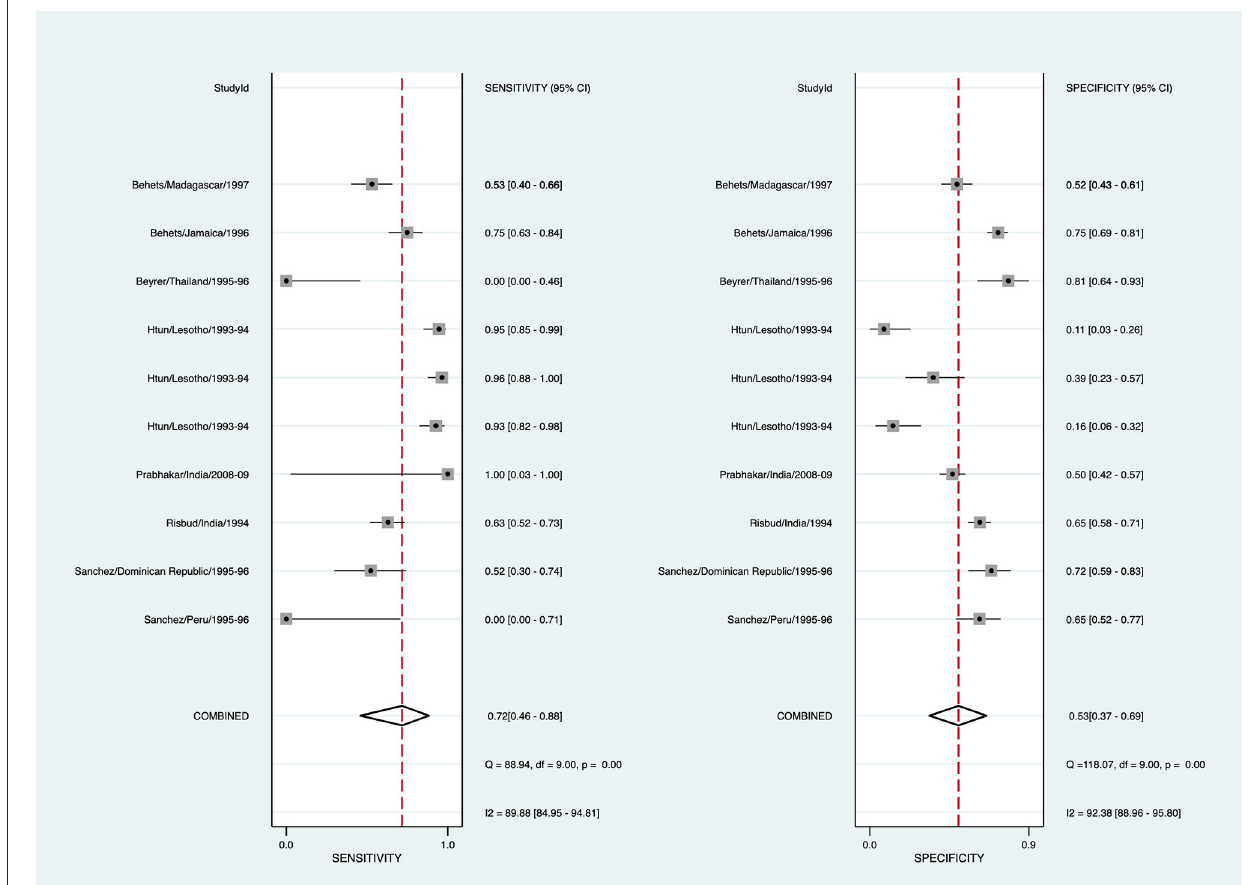
FIGURE 4 | Forest plot of the sensitivity and specificity of clinical diagnosis to detect chancroid in genital ulcer